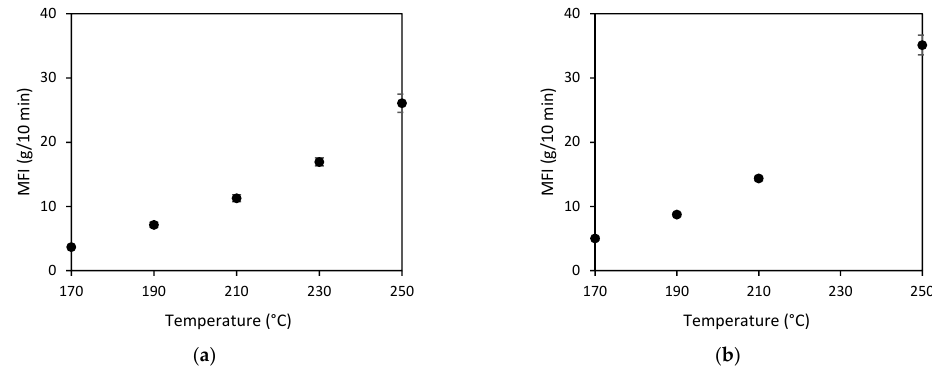
Figure 5. MFI against temperature for ( a ) PP and ( b ) PP with 3 wt% MAPP.